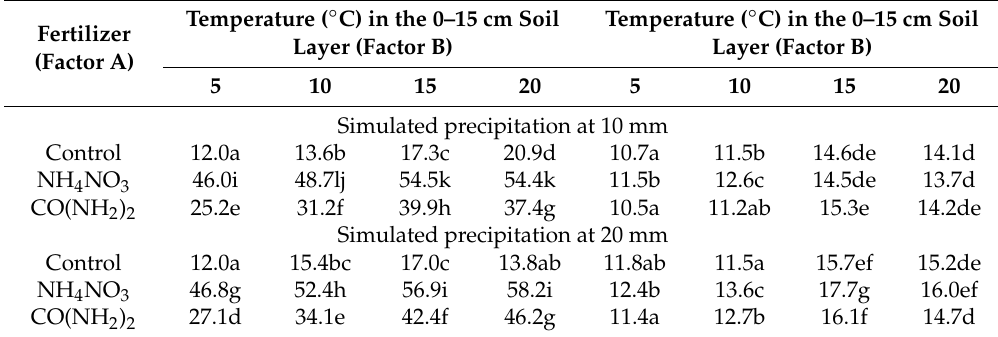
Table 1. The e ff ect of nitrogen fertilizer forms, ambient temperature, and amounts of precipitation on the changes of N min in the 0–30 cm soil